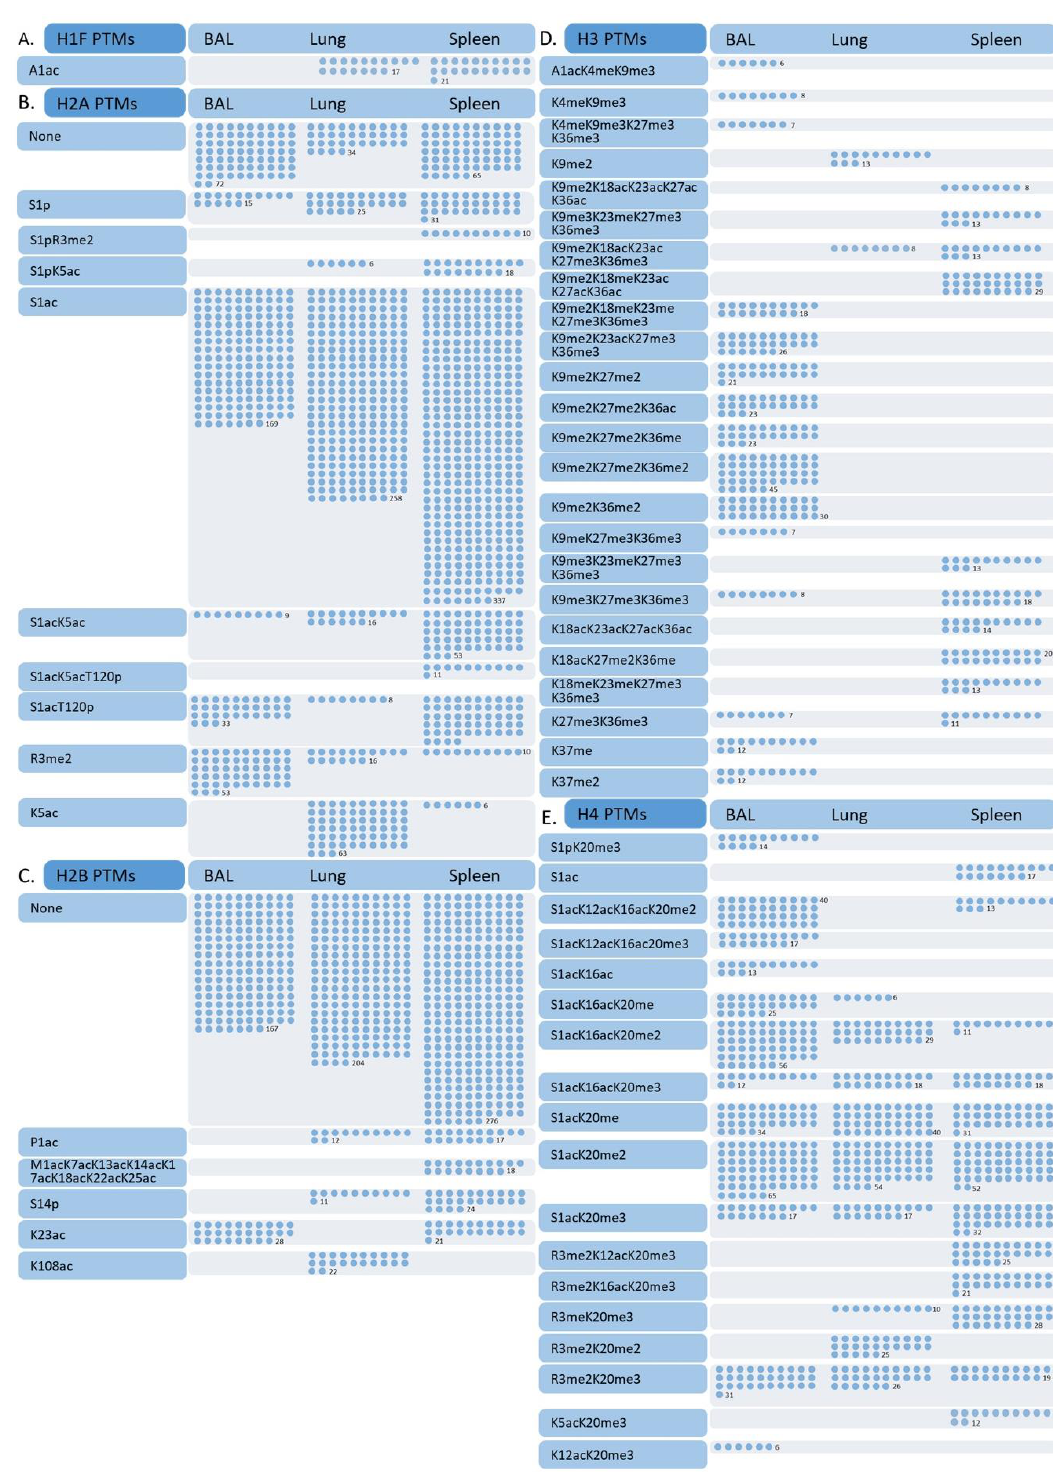
Figure 3. Distribution of modified species identified in histones purified from activated CD8 T cells isolated from BAL, lung, and spleen after influenza infection. Activated T cells were isolated from BAL, lung, and spleen 9 days after influenza infection using FACS (CD8 hi CD44 hi CD43 hi CD25 hi ). Histones were purified from each sample, subjected to activated T cells purified by FACS of splenocytes from mice 9 days after intranasal infection with influenza, and subjected to reversed-phase liquid chromatography (RPLC)–MS / MS-CID / ETD. Fragment ions identified per modified species ( • ) are indicated in score charts for H1F ( A ), H2A ( B ), H2B ( C ), H3 ( D ), and H4 ( E